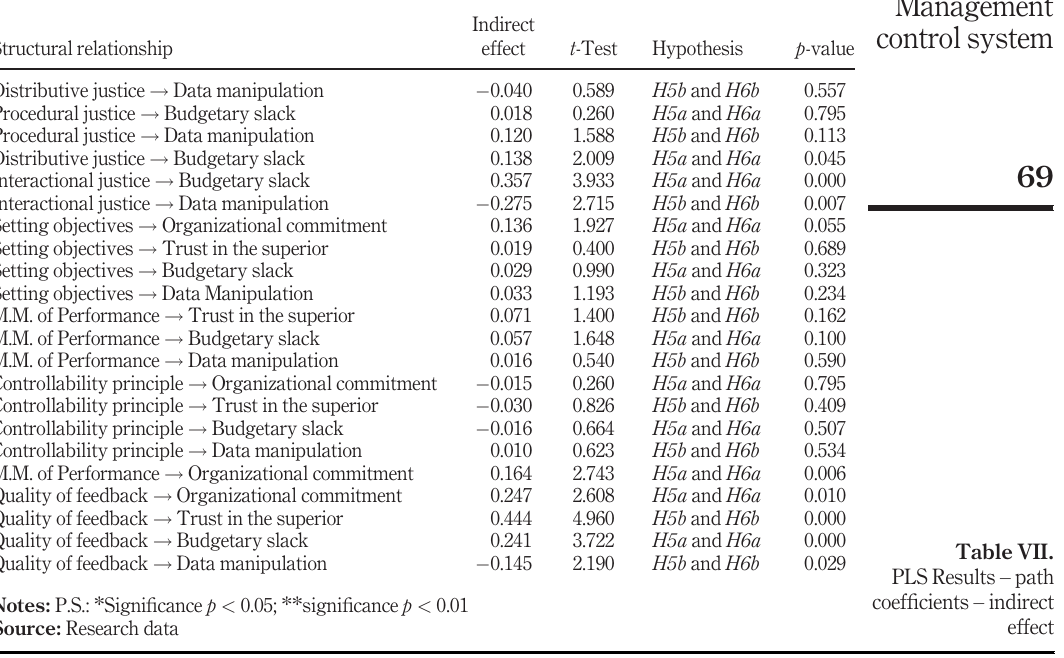
Table VII. PLS Results – path